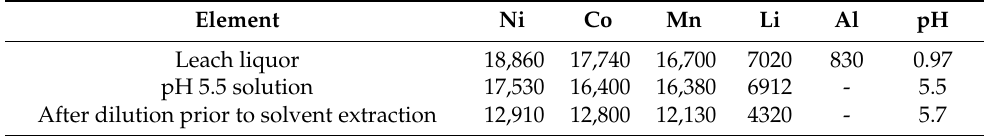
Table 3. Metal concentration of leachate by reductive leaching and pH controlled liquor (mg/L) (1 M H 2 SO 4 , 10 vol % H 2 O 2 , a reaction temperature of 60 ◦ C, an agitation speed of 250 rpm, a solid/liquid ratio of 100 g/L, and a reaction time of 2 h).